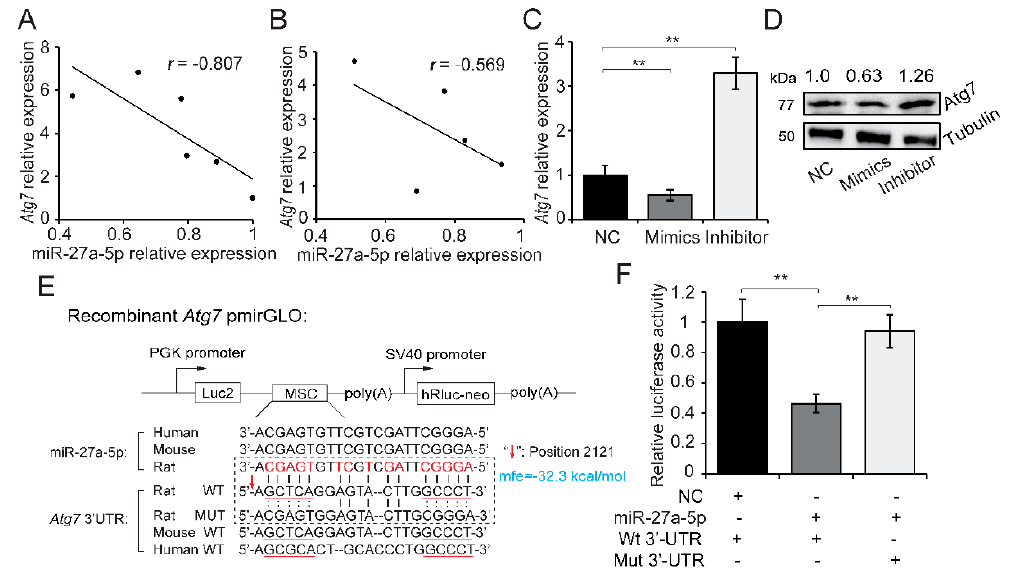
Figure 5. Atg7 is a direct target of miR-27a-5p. Relative expression correlation analysis between miR-27a-5p and Atg7 during hypoxia at di ff erent timepoints (0, 3, 6, 12, 24 and 48 h after hypoxia) in H9c2 cells ( A ), and in AMI / sham rat visceral tissues ( B ). mRNA ( C ) and protein ( D ) expression of Atg7 was tested by qRT-PCR and western blotting after miR-27a-5p gain and loss of function in hypoxia-exposed H9c2 cells. ( E ) Schematic diagram showing the structure of dual-luciferase reporter plasmid pmirGLO and the sequence alignment of miR-27a-5p and Atg7 3 (cid:48) -UTR among several representative species (human, mouse and rat). Atg7 3 (cid:48) -UTR containing the miR-27a-5p binding site (WT or MUT) was inserted into the multiple cloning site (MSC) of pmirGLO plasmid. ( F ) Luciferase activity was analyzed after co-transfection of recombinant plasmid (WT or MUT) with miR-27a-5p mimic or control into HeLa cells. Three independent experiments were performed in triplicate. Data are expressed as the mean ± SD. ** p < 0.01. NC: negative control; mfe: minimum free energy.